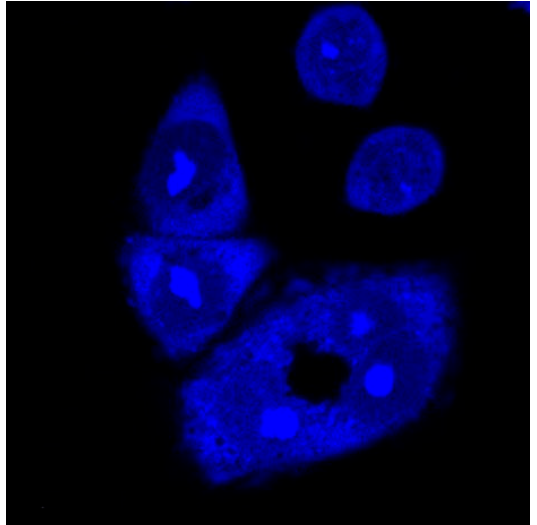
Figure 9. Intracellular distribution of dye 4 . Confocal microscopy of live HeLa cells taken on Leica SP8 X confocal microscope, stained with 1 μ M of compounds 4 ( λ exc = 405 nm, λ em = 470–670 nm).